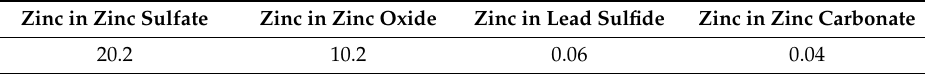
Table 1. Main chemical composition of the oxidizing roasting cinder (wt %). Table 2. Lead phase analysis of the oxidizing roasting cinder (wt %). Table 2. Lead phase analysis of the oxidizing roasting cinder (wt %). Table 3. Zinc phase analysis of the oxidizing roasting cinder (wt %). Table 3. Zinc phase analysis of the oxidizing roasting cinder (wt %).